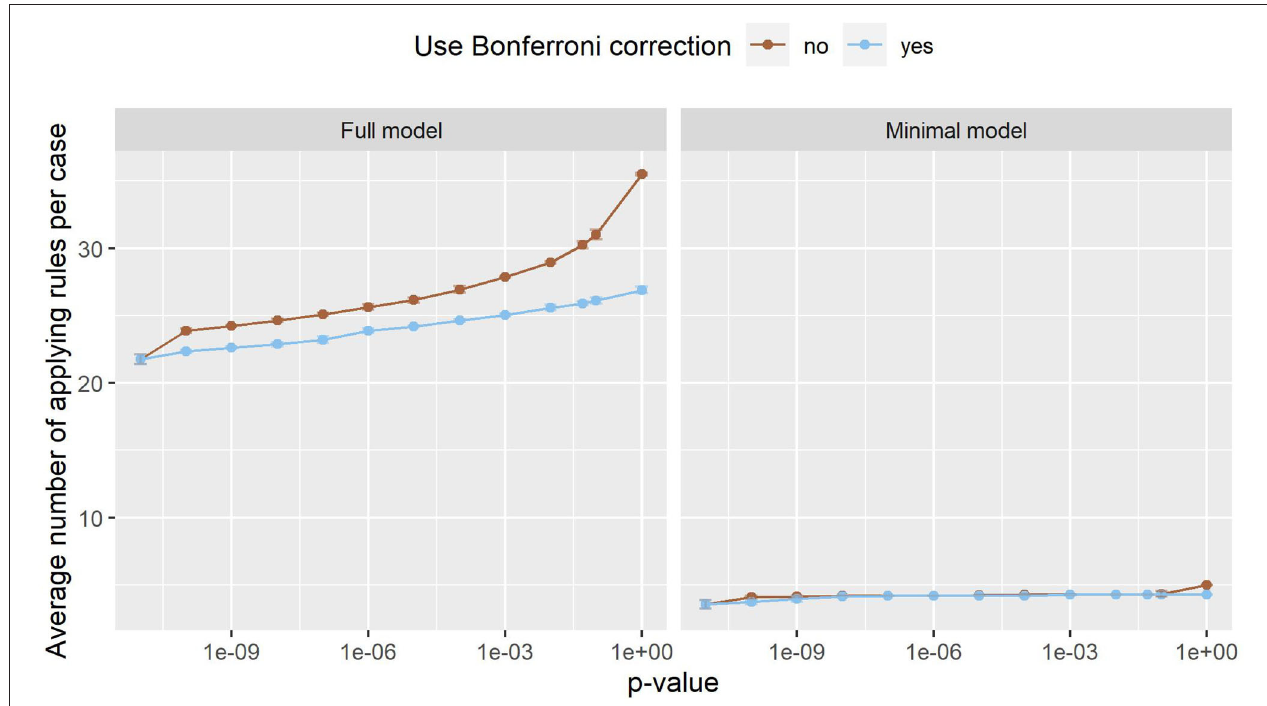
FIGURE 4 | The number of rules that apply to an average case in the full model (left) and the minimal model (right). Error bars (which are very small) show one standard deviation, the color indicates whether Bonferroni correction was used. The x-axis shows different p -values used in the filtering step. The leftmost dot denotes the p -value zero. Only a small fraction of all rules apply to an individual case, making it easy to interpret the model and its decisions.